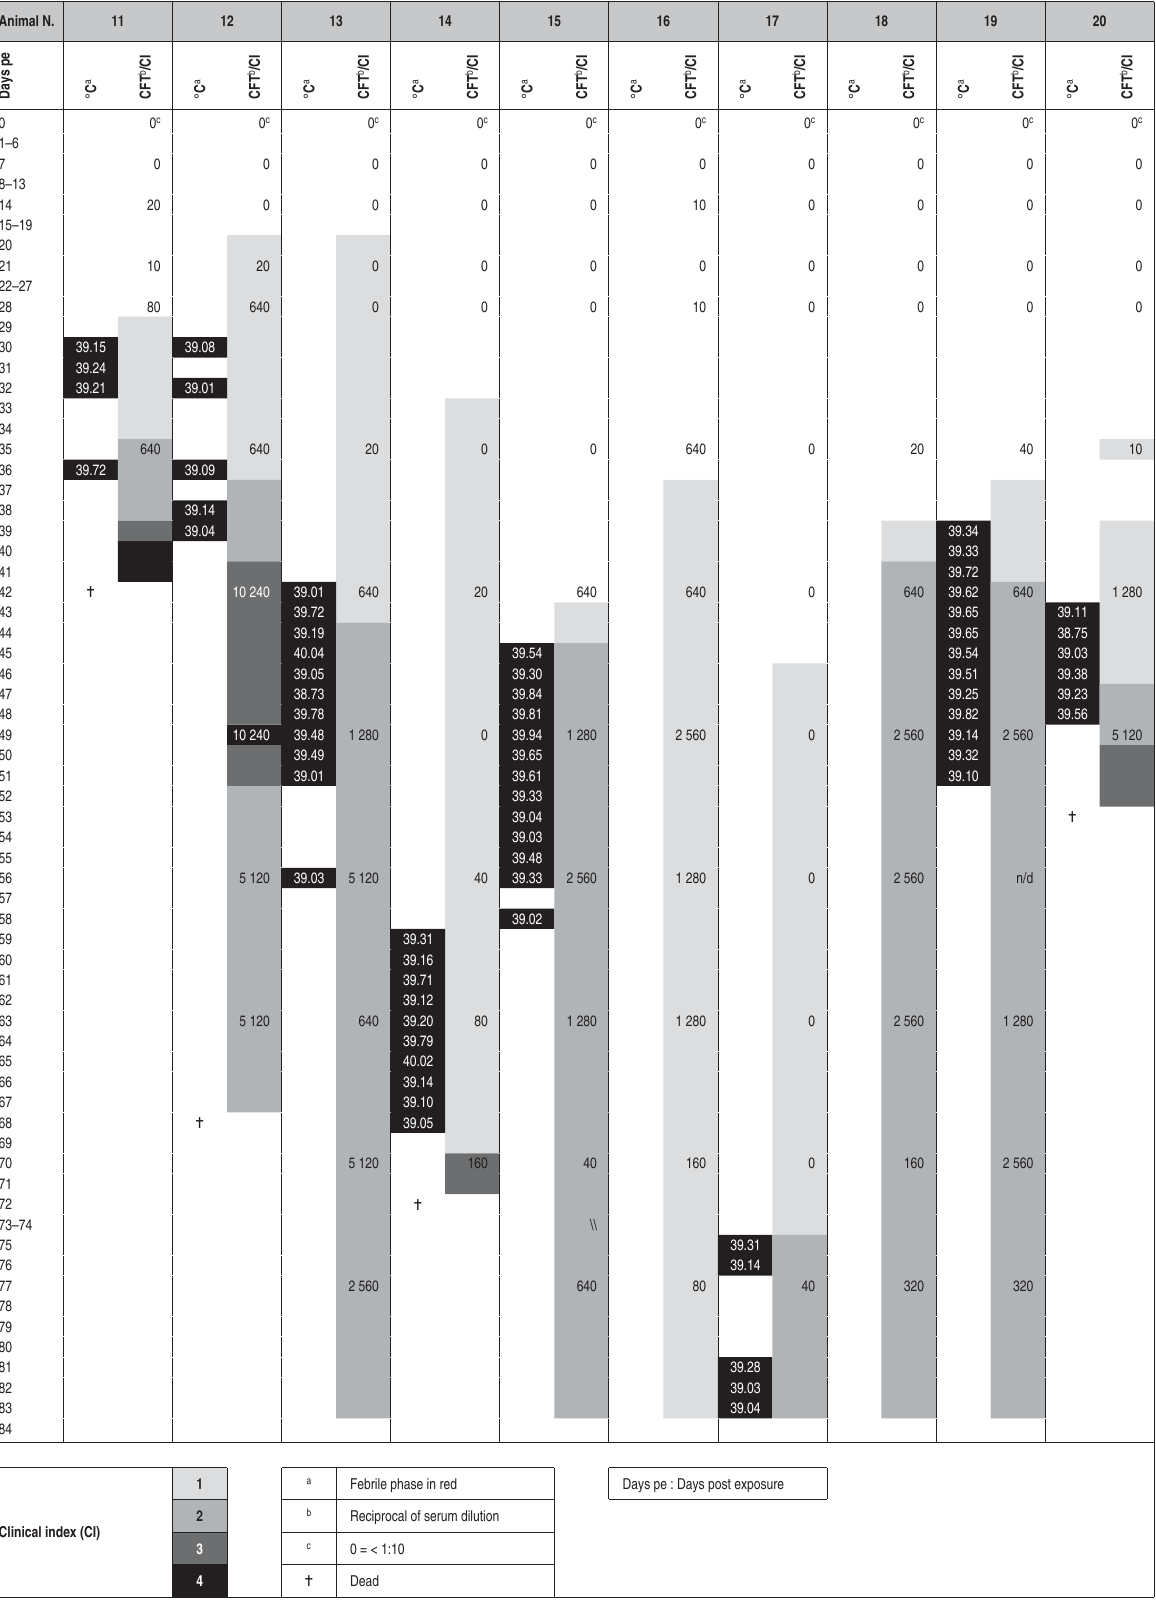
TABLE 3 Events following contact infection of untreated cattle Animal